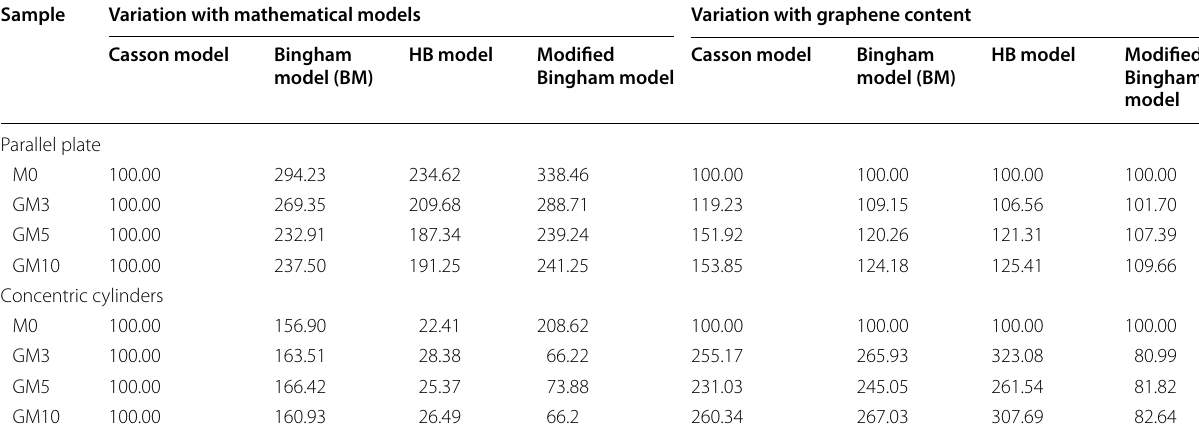
Table 5 Variation of yield stress with mathematical models and graphene content. Sample